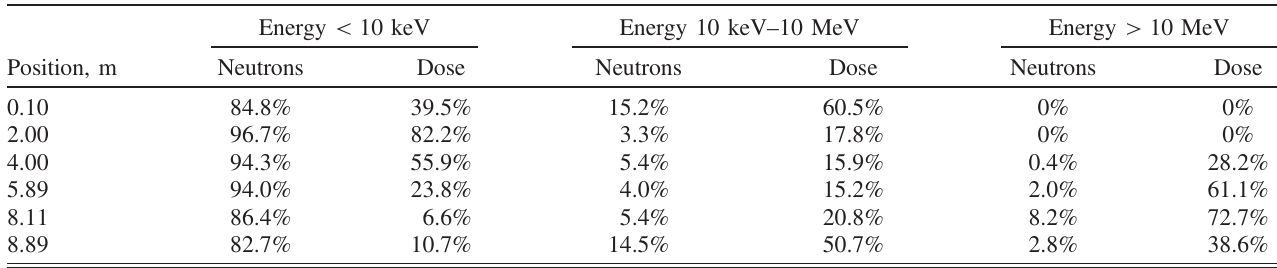
TABLE II. Data presented in the table show the relative number of neutrons and the dose rates due to these neutrons in a certain energy range calculated at various positions from the simulation results. Positions are given with respect to BOA